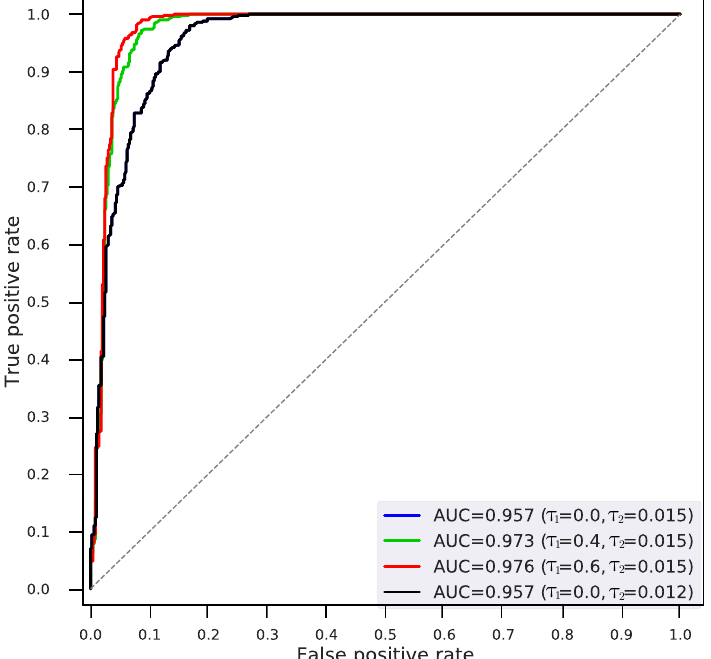
Figure 7. ROC curves of tampering detection results using our RFM-based detector with various thresholds τ 1 and τ 2